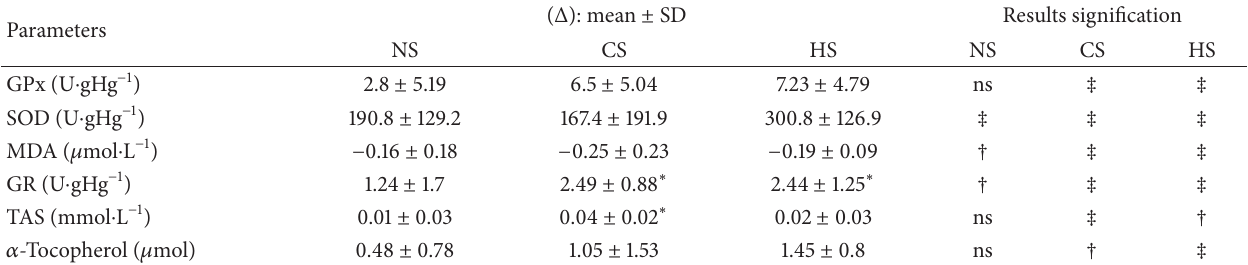
Table 3: Antioxidants’ improvement rate ( Δ ) of the three groups after 12 weeks of intermittent training. Parameters